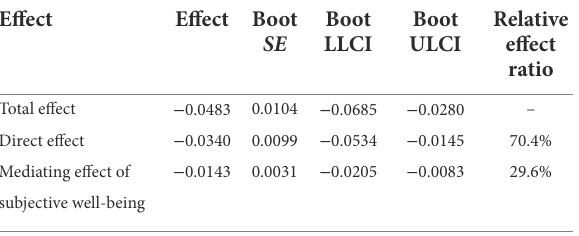
TABLE 5 Total, direct, and mediating